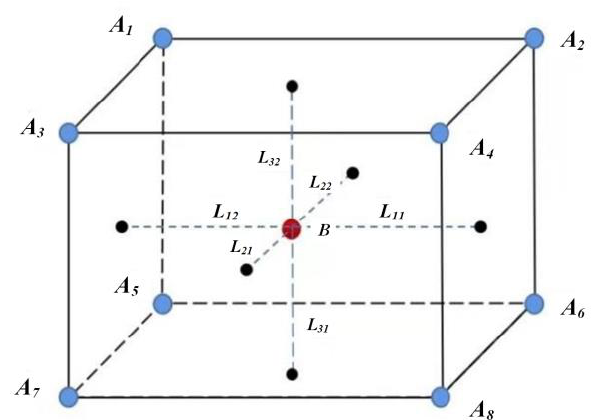
Figure 6. CCM for three-dimensional ISSD.